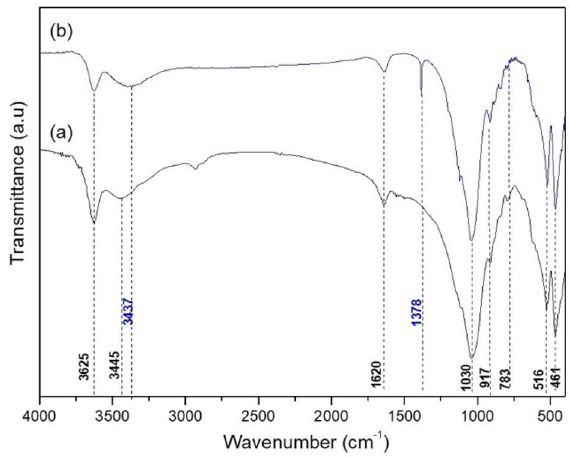
Figure 2. Infrared spectra: ( a ) MMt; and ( b )